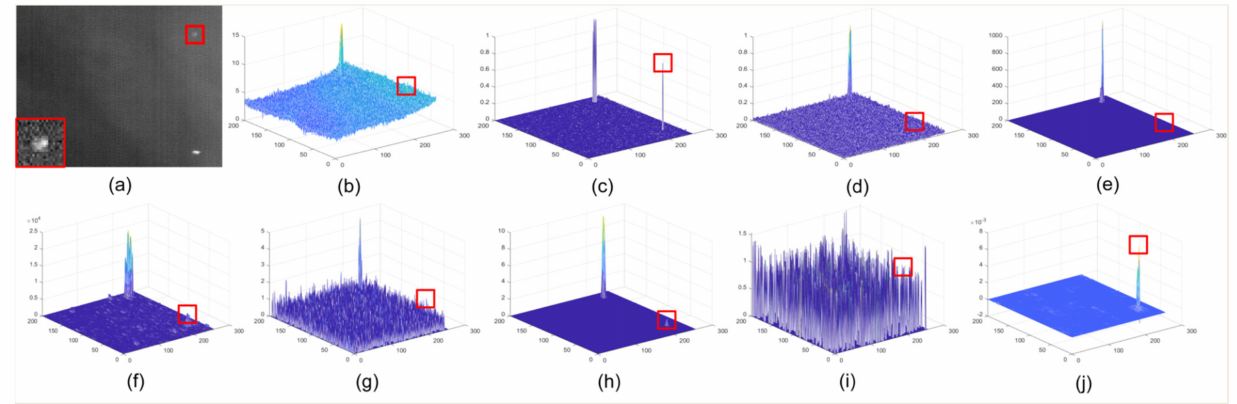
Figure 7. Detection results of different methods in Seq.2. ( a ) raw image, the details of target are magnified at the left bottom corner; ( b ) three-view of raw image; ( c ) result of STLCM; ( d ) result of STLCF; ( e ) result of FSM; ( f ) result of NSM; ( g ) result of STJP; ( h ) result of DNGM; ( i ) result of MLTC; ( j ) result of LSM.